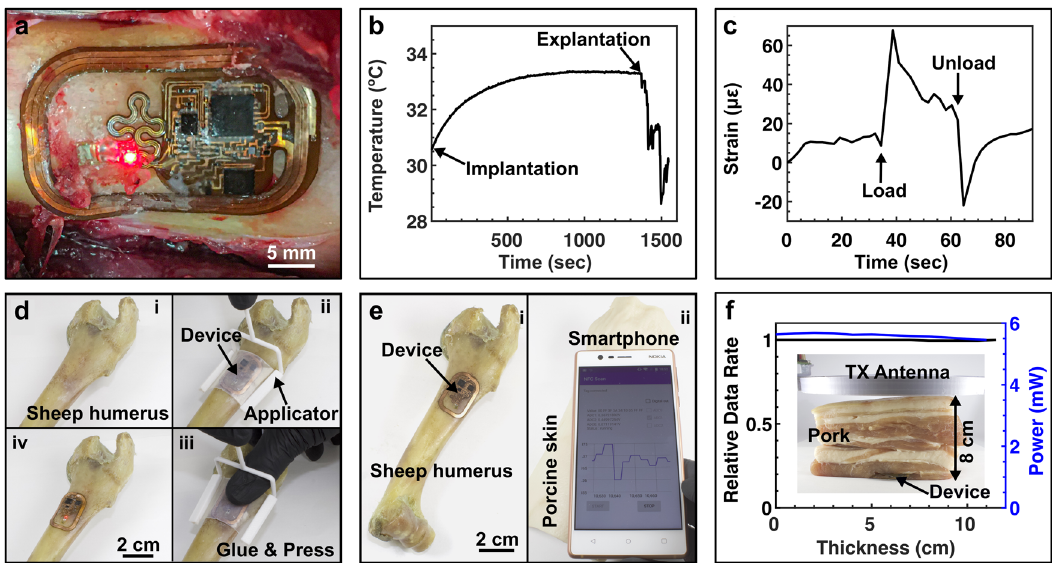
Fig. 7 In situ studies in sheep and diagnostic application. a Photograph of a wirelessly powered osseosurface electronic device attached on a sheep humerus. b Temperature pro fi le during implantation surgery on sheep humerus recorded wirelessly through tissue. c Strain pro fi le of 3-point bending test of sheep humerus recorded wirelessly through tissue. d Tools and strategy to attach osseosurface devices on the bone: i. bone surface is cleaned by sanding; ii. device with applied glue is brought into contact with the bone surface with applicator; iii. device is pressed fi rmly with fi nger; and iv. applicator is removed. e Photos of demonstration of real-time signal recording through porcine skin (~1 cm thick) using an NFC-enabled smartphone: i. device attached on the sheep humerus; and ii. device covered by porcine skin and real-time signal readout with NFC-enabled smartphone. f Relative data rate and power availability as functions of tissue thickness. Inset shows photograph of experimental